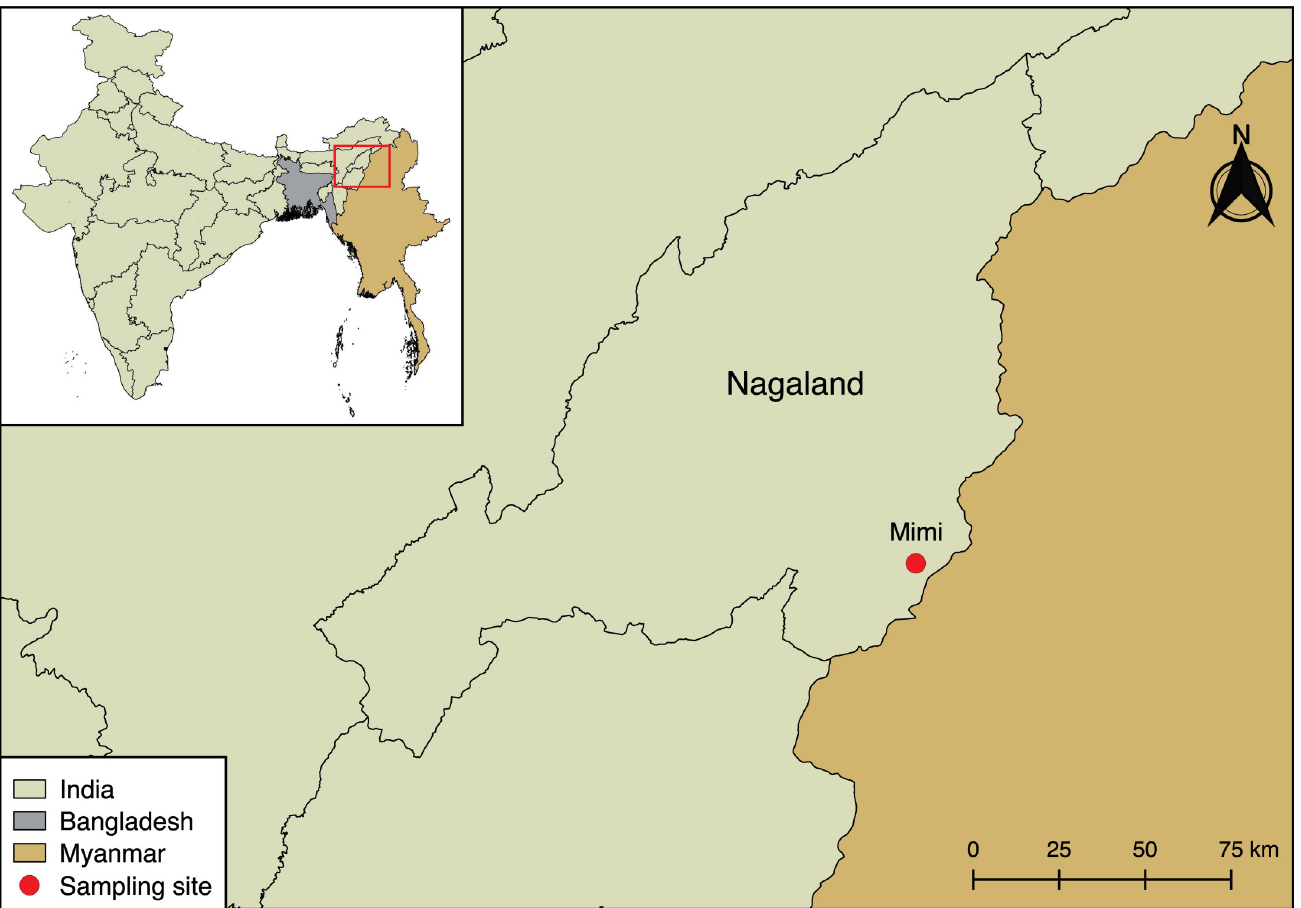
Fig 1. Geographical map of the border region between India and Myanmar. The Indian state of Nagaland and Mimi village are indicated. The map was created using QGIS v2.18.7 software (https://qgis.org/en/site/). The India shapefile was downloaded from the India Remote Sensing and GIS website (http://www. indianremotesensing.com/) and the Bangladesh and Myanmar shapefiles were downloaded from DIVA-GIS (http://www.diva-gis.org/gdata). All layers were in the geographic coordinate system WGS 84 and all software and map layers used are open access.